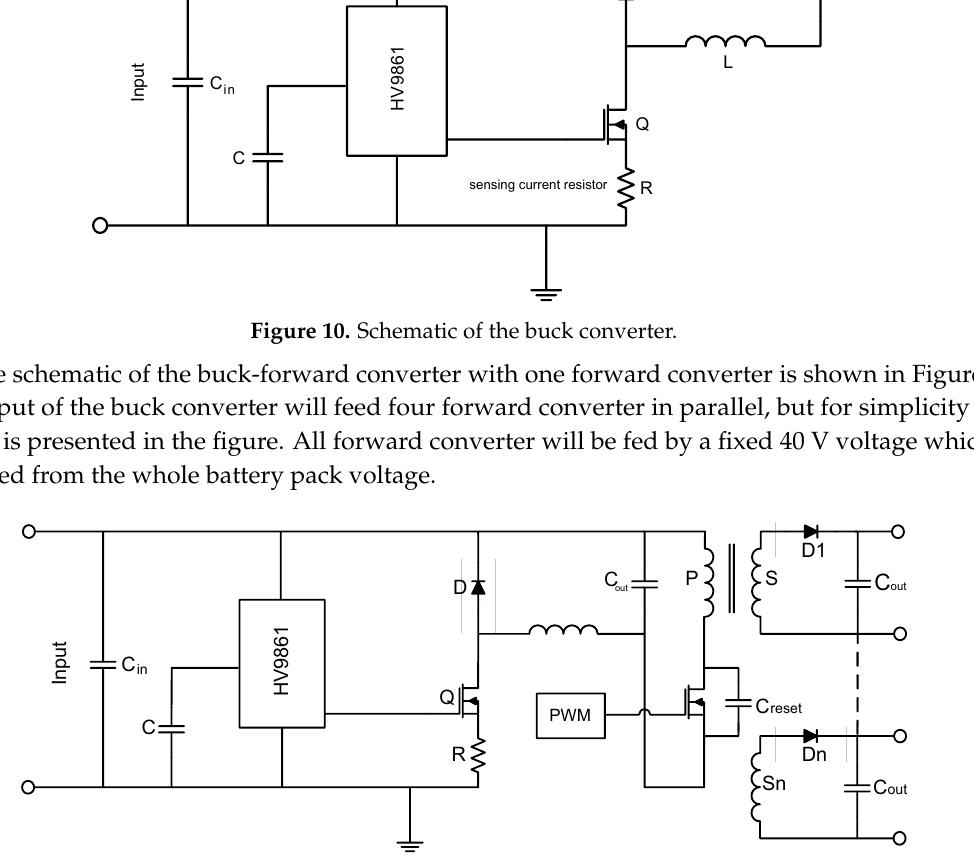
Figure 11. Schematic of the buck-forward